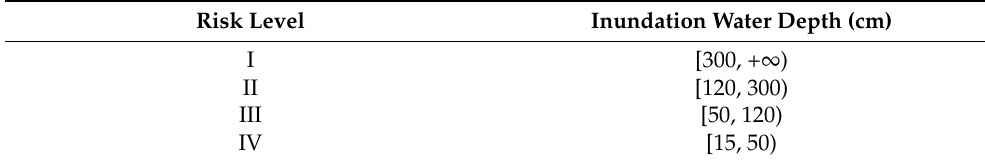
Table 2. Risk levels of inundation depth [22].